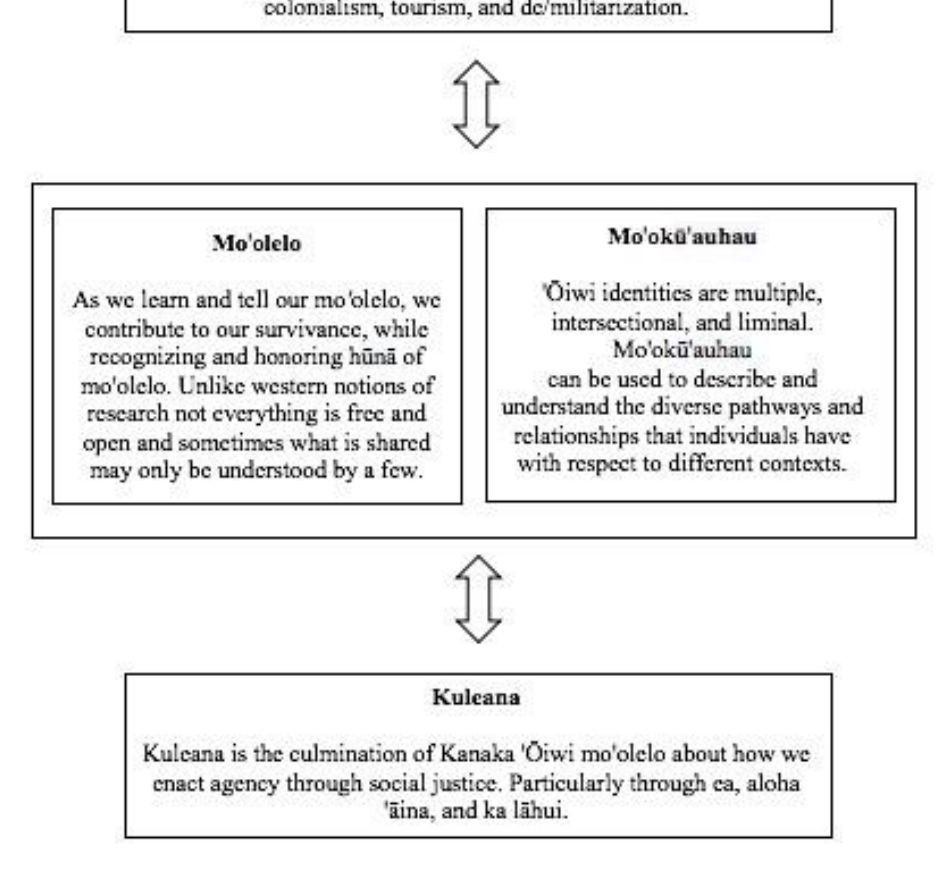
Nik Cristobal, Kanaka'ŌiwiCrit Thematic Intersections, Digital Illustration, 2018. 63